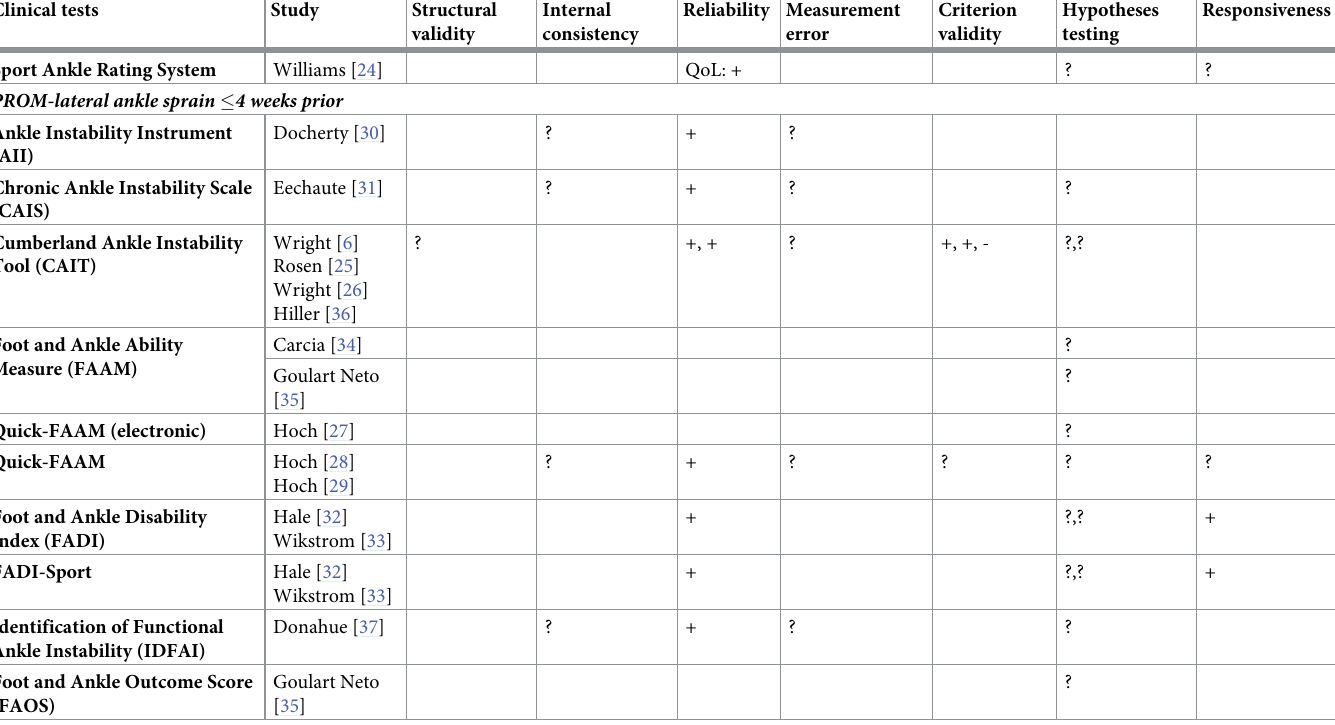
table adapted from COSMIN recommendations, Diagnostic accuracy studies are not mentioned as grading of measurement properties was not possible with these study